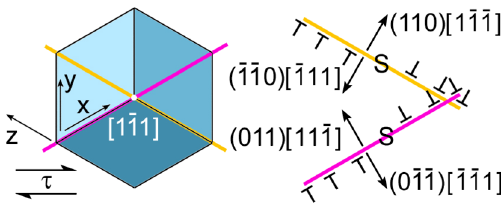
FIG. 2. (Color) Two f 110 g slip planes with a common [111] axis perpendicular to the page are illustrated on a cubic unit cell. Motion of dislocations from sources S arise due to an imposed shear stress (cid:1) that activates two slip systems. The plane normal and slip directions are described with Miller indices such that the scalar product is zero; each system can be equivalently described in two ways using opposite signs (bars over numbers).